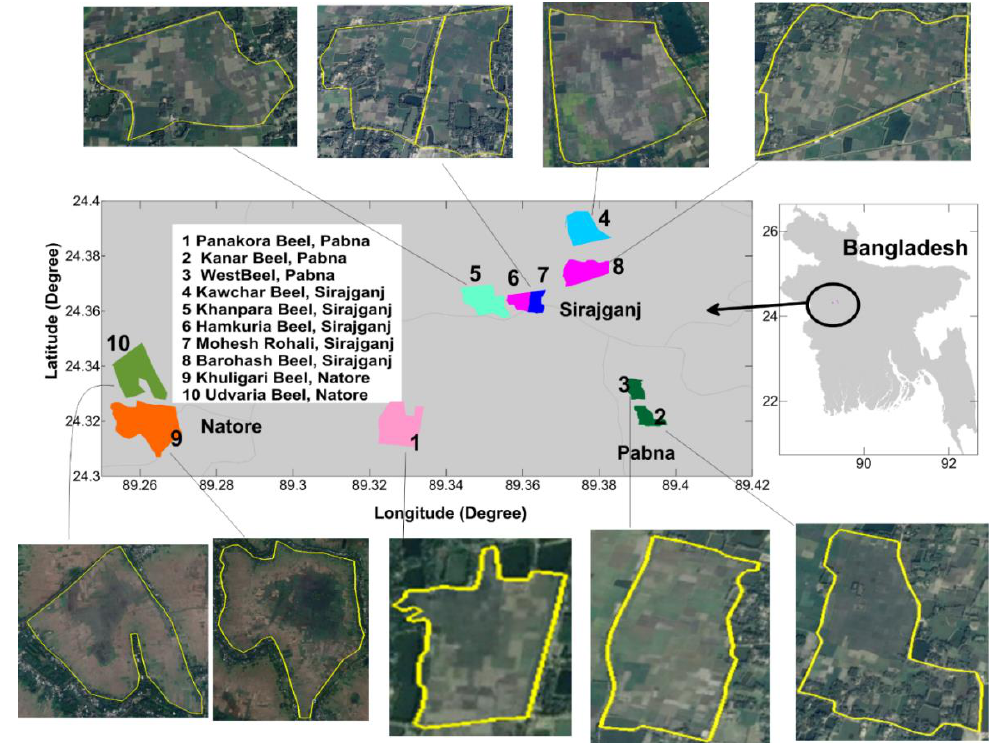
Figure 1. Location of study area and sampling sites in the Chalan beel area. Here, Panakora beel (CB 1); Kanar beel (CB 2); Western beel (CB 3); Kawchar beel (CB 4); Khanpara beel (CB 5); Hamkuria